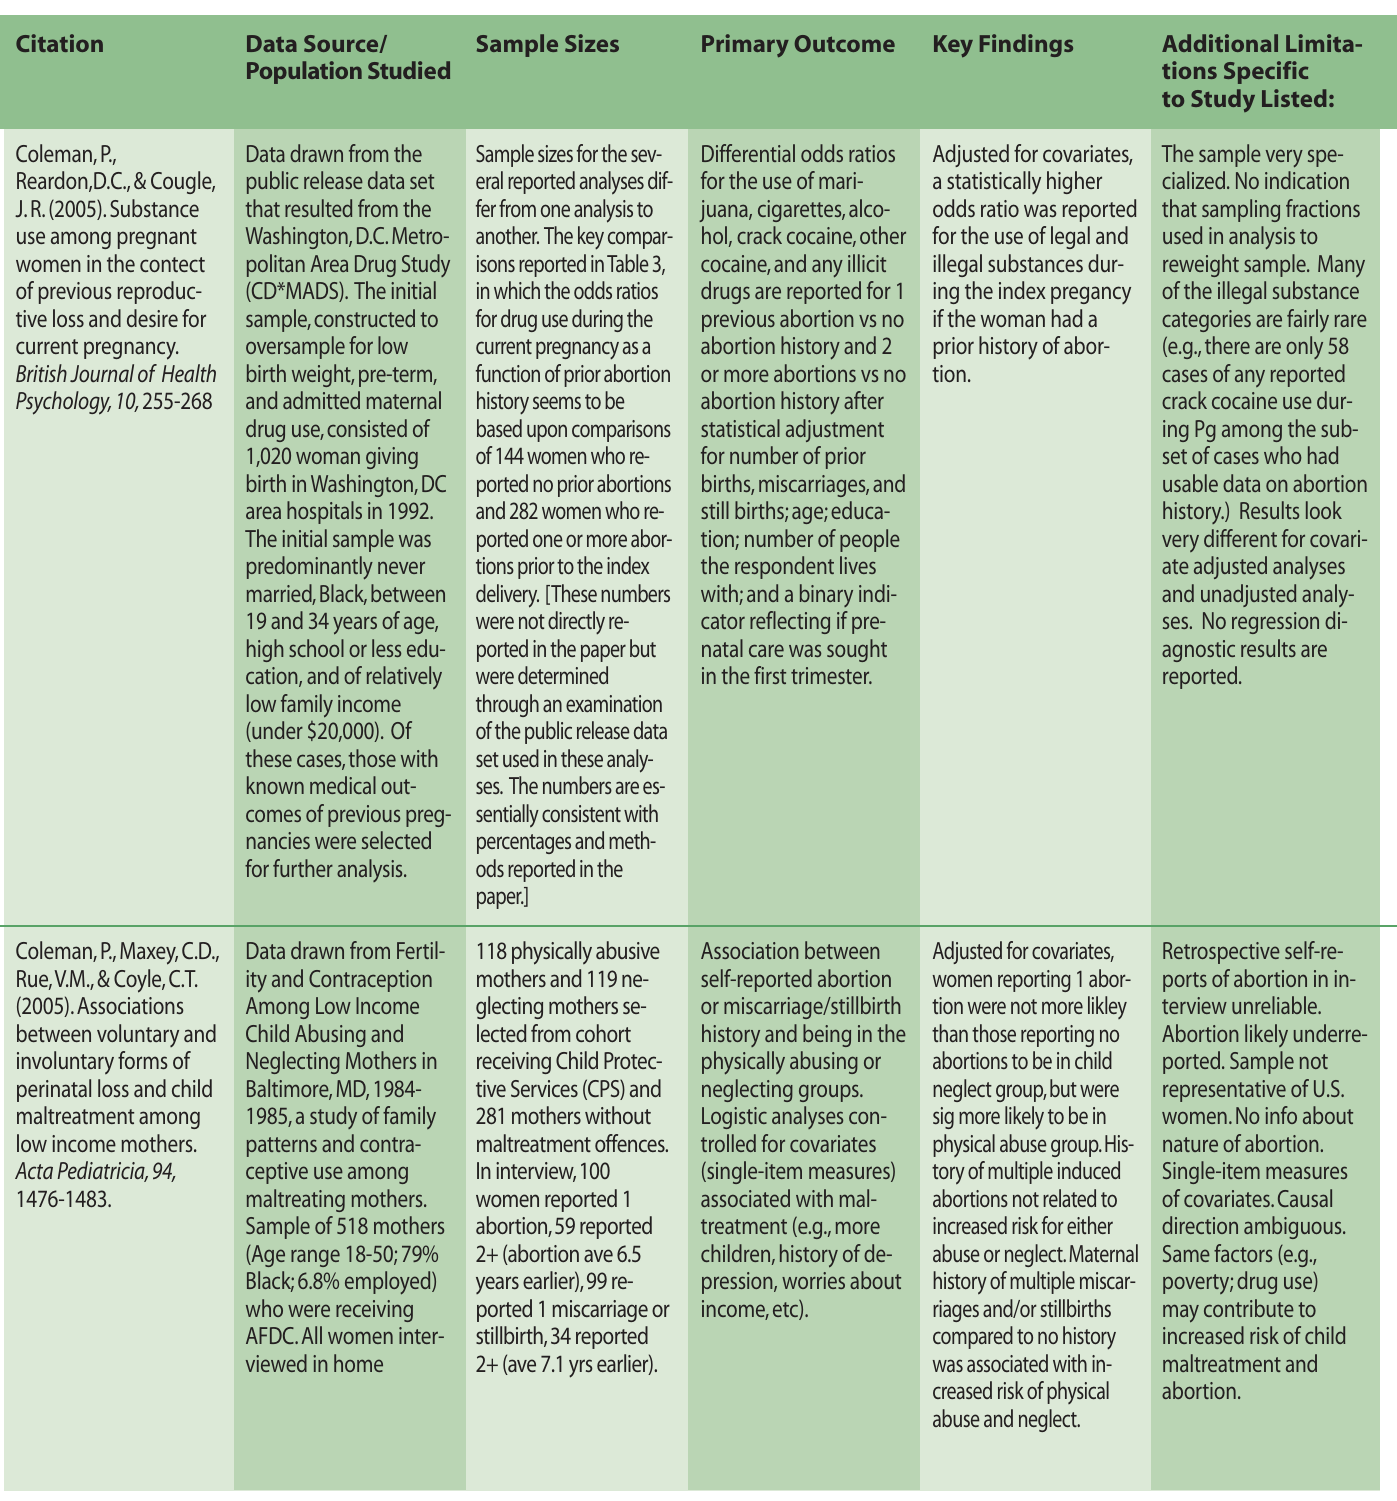
Table 1B: Secondary Analyses of Survey Data–Abortion vs.Comparison Groups U.S.STUDIES